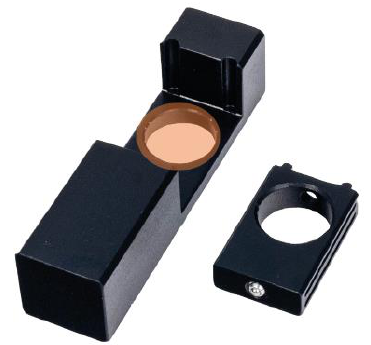
Figure 14. Image of the solid sample holder utilized for membrane analysis.